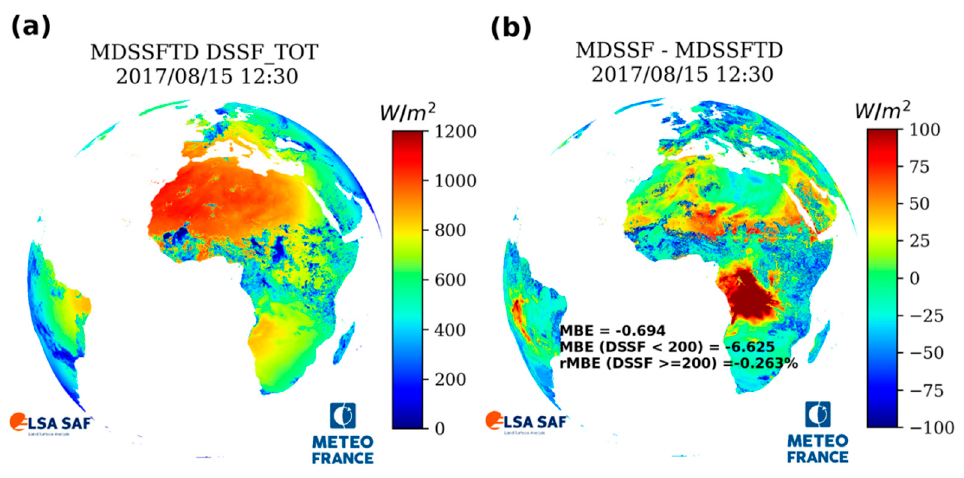
Figure 8. MDSSFTD (LSA-207) and difference with MDSSF (LSA-201) total flux (MDSSF-MDSSFTD) on the 15 August 2017 at 12:30 UTC.